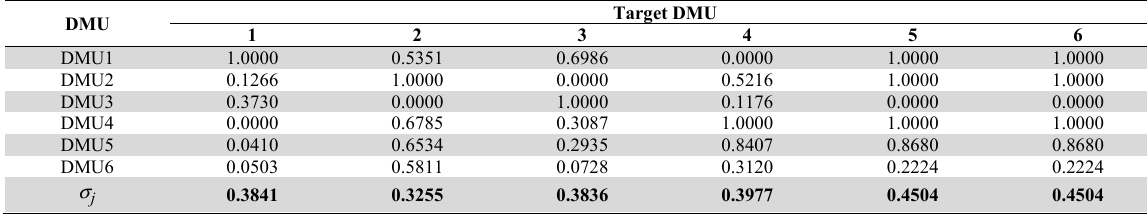
Normalized CEM of six nursing